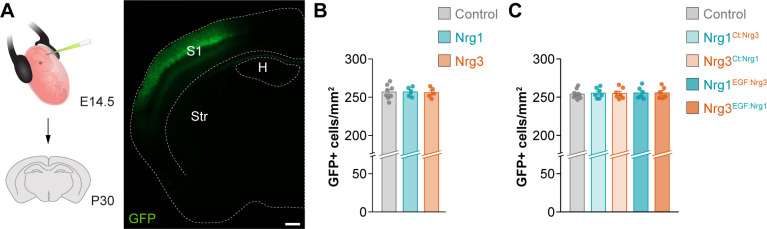
Density of electroporated cortical pyramidal cells in gain-of-function experiments, related to Figure 2.(A) Schematic of experimental design. Gain-of-function experiments were performed by in utero electroporation of the somatosensory cortex at E14.5 and analysis at P30. The coronal section illustrates the expression of GFP in a typical experiment. (B) Quantification of the density of GFP+ cells in the somatosensory cortex of mice following electroporation of control and wild-type neuregulin-expressing plasmids. One-way ANOVA, F = 0.026, p=0.975; n = 8 mice (24 regions of interest, ROIs) for pSyn-Gfp (control), 5 mice (16 ROIs) for pSyn-Nrg1-pSyn-Gfp, and 5 mice (16 ROIs) for pSyn-Nrg3-pSyn-Gfp. (C) Quantification of the density of GFP+ cells in the somatosensory cortex of mice following electroporation of control and chimeric neuregulin-expressing plasmids. One-way ANOVA, F = 0.054, p=0.994; n = 8 mice (30 ROIs) for pSyn-Gfp (control), 7 mice (24 ROIs) for pSyn-Nrg1Ct:Nrg3-pSyn-Gfp, 7 mice (24 ROIs) for pSyn-Nrg3Ct:Nrg1-pSyn-Gfp, 6 mice (22 ROIs) for pSyn-Nrg1EGF:Nrg3-pSyn-Gfp, and 6 mice (22 ROIs) for pSyn-Nrg3EGF:Nrg1-pSyn-Gfp. Scale bar, 400 µm. Data are shown as mean ± s.e.m. Data used for quantitative analyses are available in Figure 2—figure supplement 1—source data 1.
Figure 2—figure supplement 1—source data 1.Numerical data of GFP+ cell densities in gain-of-function experiments.